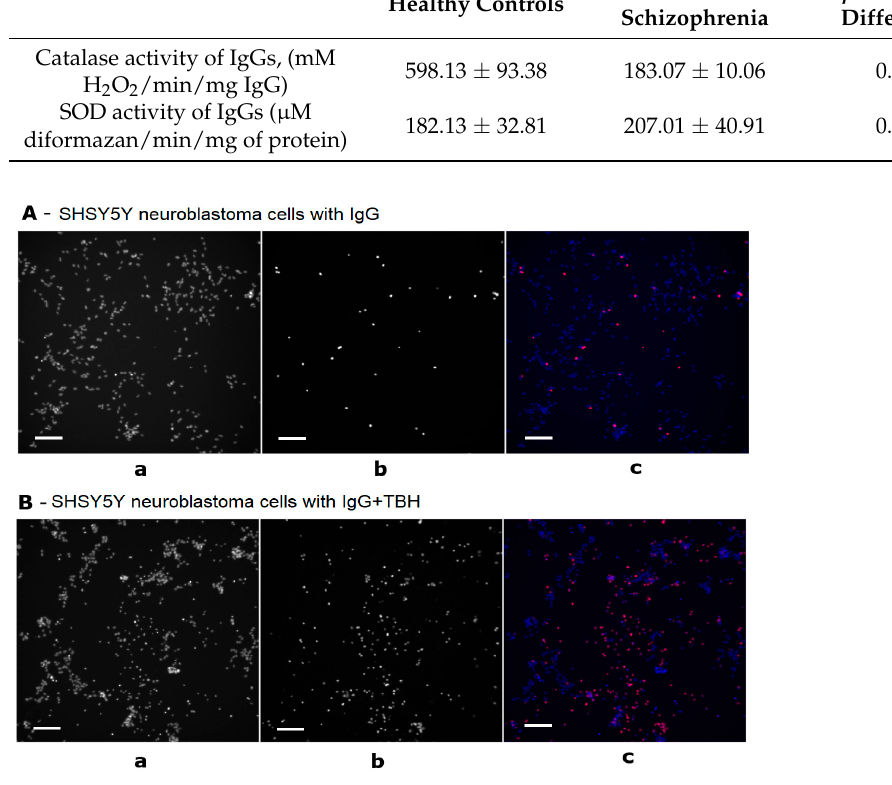
with Hoechst + propidium iodide. Scale bars: 100 µm.